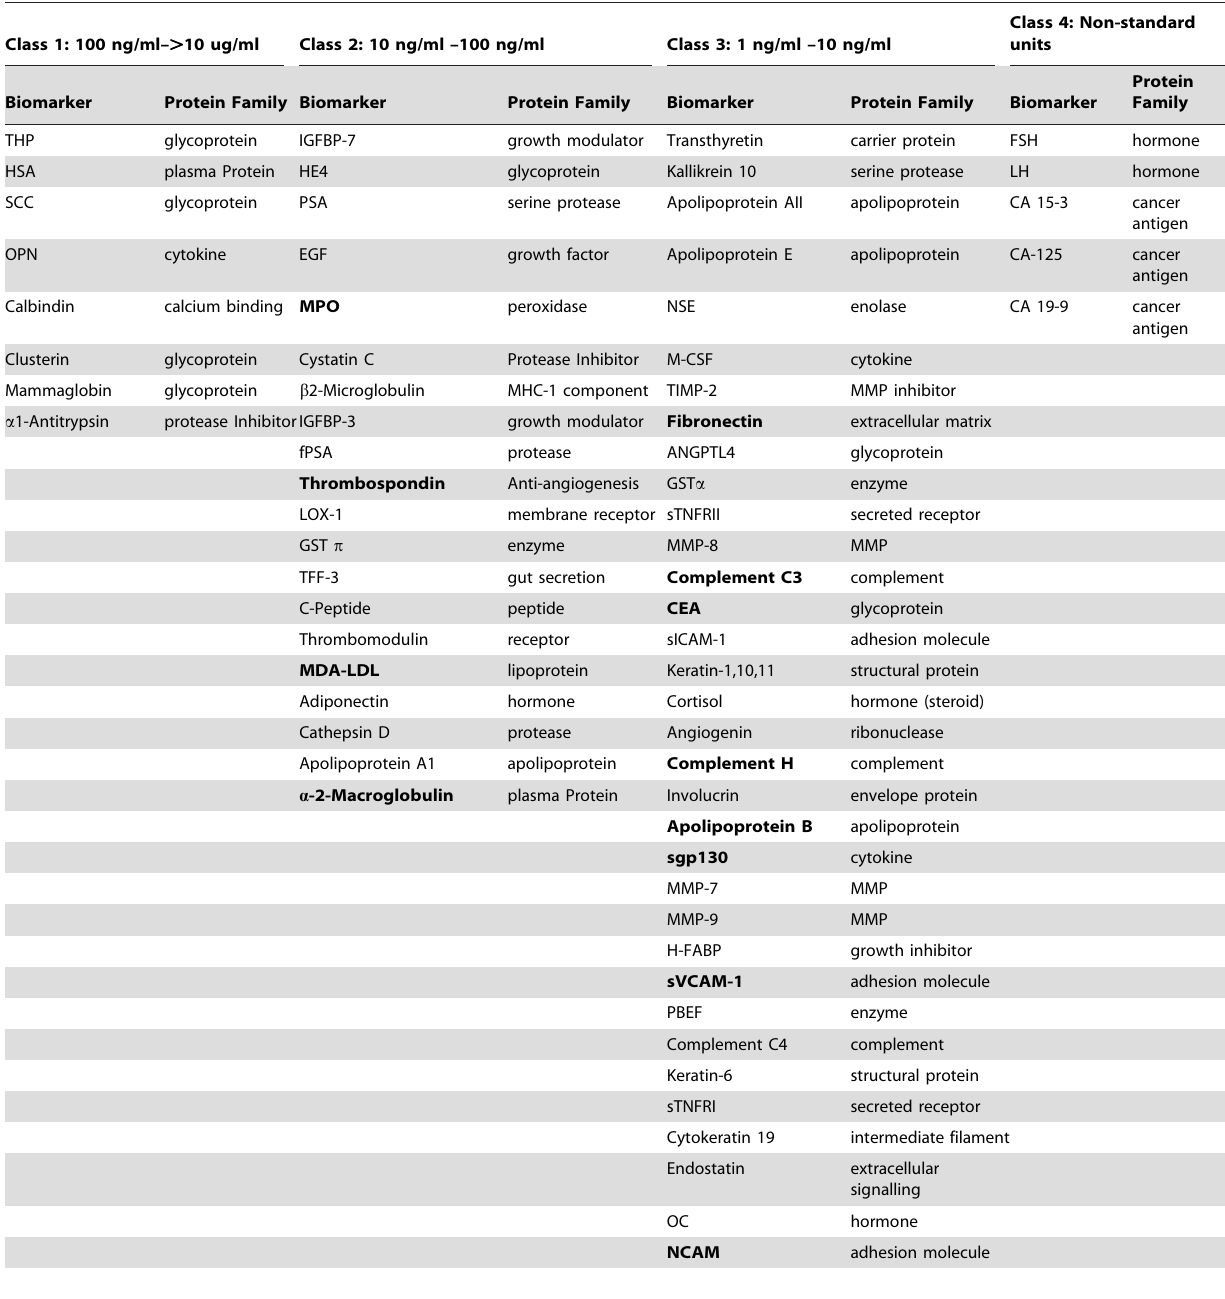
Table 2. Relative Abundance classes of urine protein